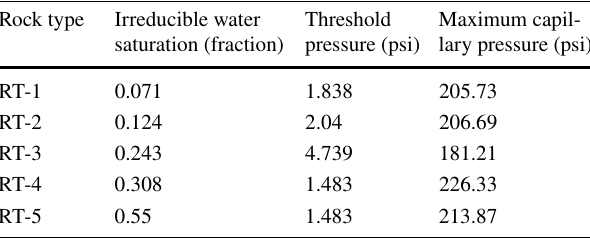
Table 2 Values obtained for endpoints of the capillary pressure curves for water–oil drainage process Rock type